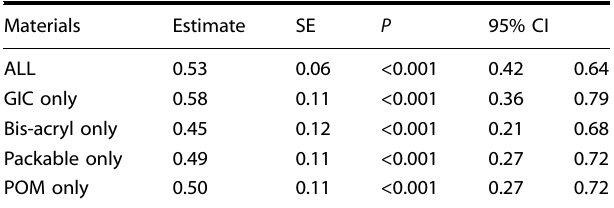
Table 4. Auto-regressive